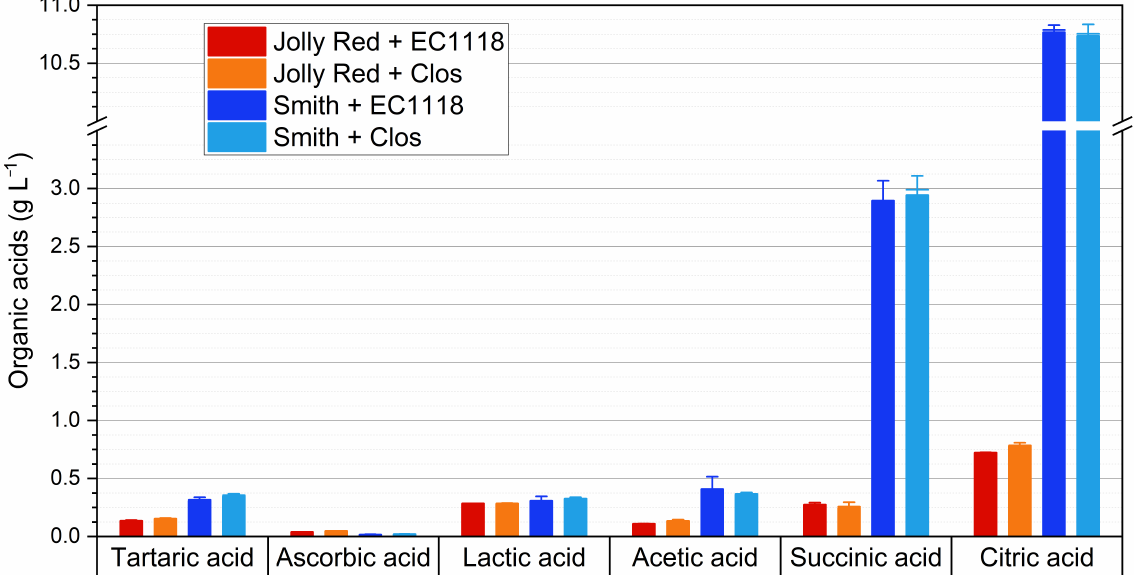
Figure 2. Contents of organic acids of the pomegranate wines from the four cultivar × yeast combinations tested. Data are averages ± standard deviations of three replicates per